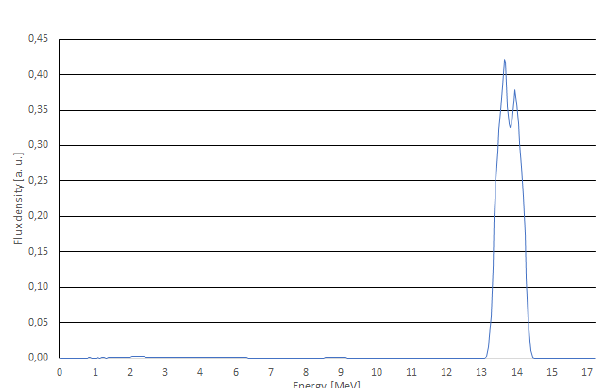
Figure 7. Results of the simulated neutron spectra for the IEC neutron generator.